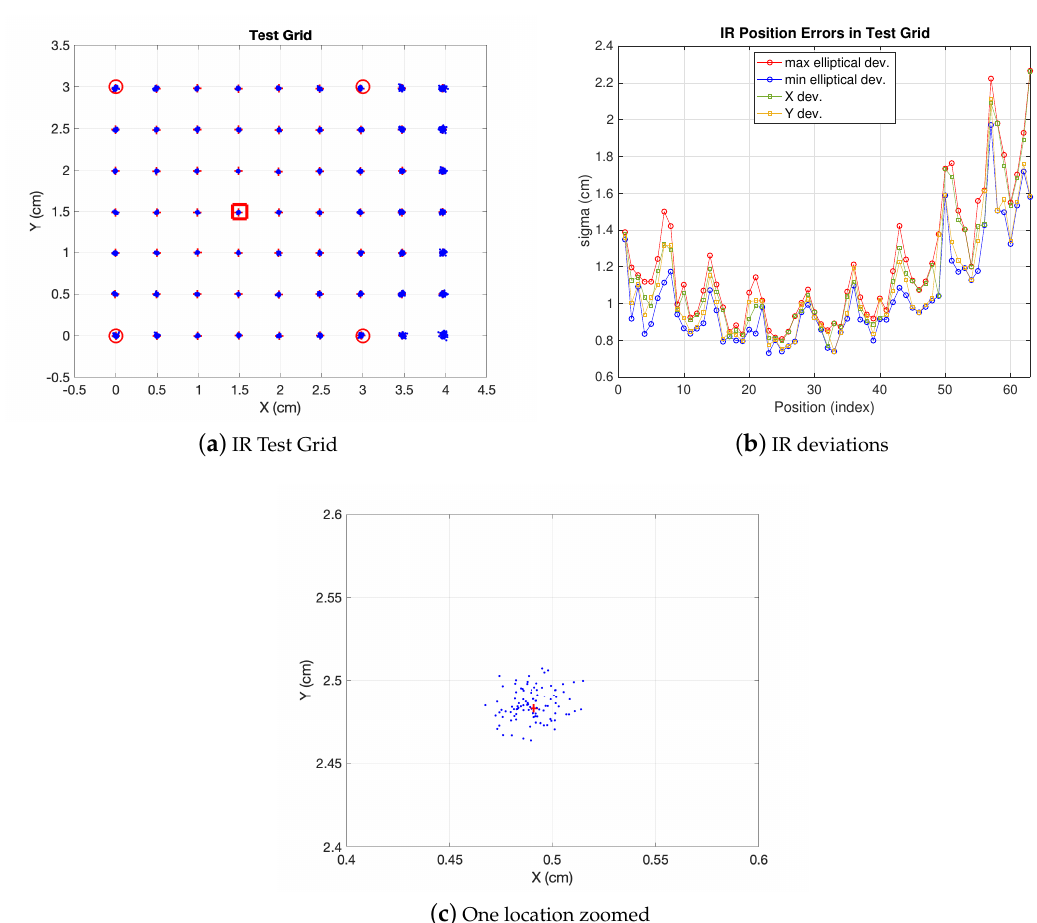
Figure 3. IR errors. Red markers indicate anchor projections on grid plane (red square is